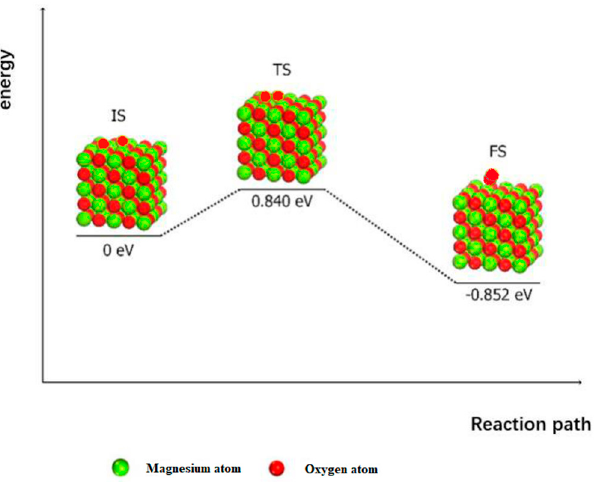
Figure 5. The surface reduction process of MgO (100) following the Langmuir–Hinshelwood (LH) mechanism.